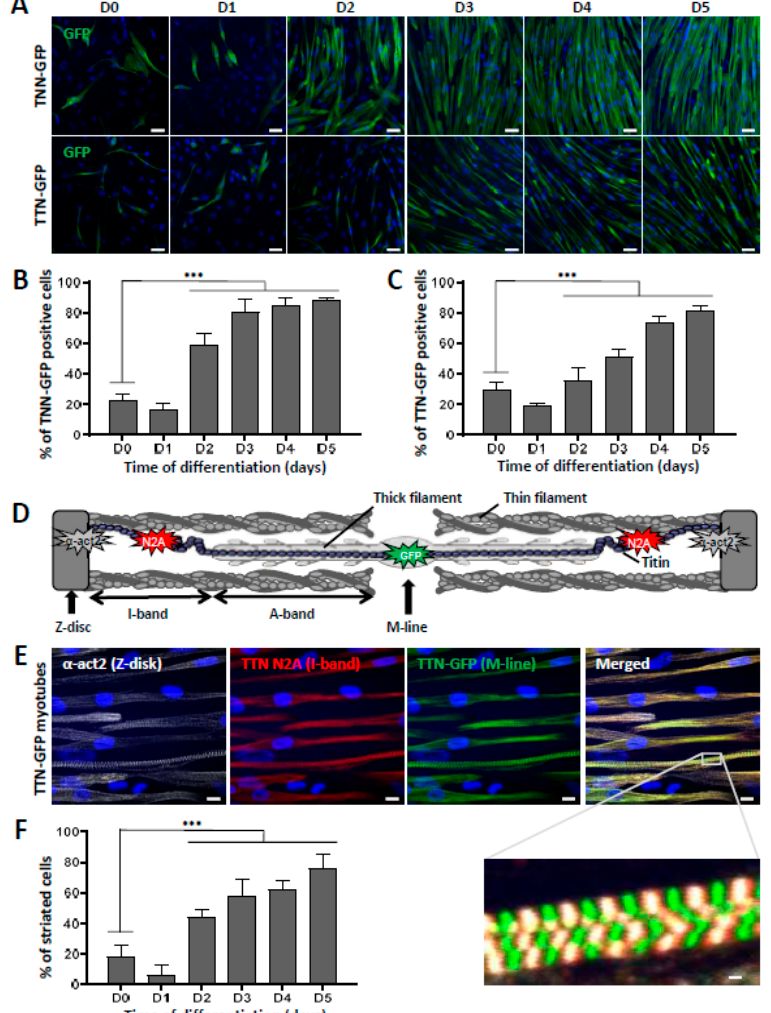
Figure 2. Striation pattern appears during terminal myogenic differentiation. ( A – C ): Troponin I(TNN)- and titin(TTN)-eGFP dynamics during myotube maturation. ( A ) Confocal images of TNN- and TTN-eGFP-tagged cell lines were obtained from day 0 to day 5 after induction of myotube maturation. Nuclei were labeled by Hoechst staining. Scale bar = 50 µ m. Quantification of the percentage of cells terminally differentiated, presented as the percentage of ( B ) TNN- or ( C ) TTN- positive cells out of the total number of myotubes. Each chart represents the mean +/ − SD (n = 5) for a representative experiment; *** p ≤ 0.005 (Student’s t -test). ( D – F ): Analysis of sarcomeric organization during myotube maturation. ( D ) Schematic representation of sarcomeric architecture in skeletal muscle: Z-disk composed of α -actinin, I-band made up of actin thin filaments, A-band comprised of myosin thick filaments, and the M-line where filaments are anchored. Titin spans the entire half-sarcomere: from the Z-disk with the N-terminal extremity to the M-line, by way of the I-band, specifically recognized by the titin N2A antibody. ( E ) Immunofluorescent staining and confocal acquisition of sarcomere structures with TTN-eGFP-tagged cells at day 5 of myotube maturation. Nuclei are labeled by Hoechst staining. Scale bar = 10 µ m. White box denotes an enlargement of co-staining to visualize the cross-striation pattern of myotubes. Scale bar = 1 µ m. ( F ) Quantification of the number of striated cells relative to the total number of skMt during time course differentiation of the TTN-eGFP-tagged cell line. Each chart represents the mean +/ − SD (n = 10) for a representative experiment; *** p ≤ 0.005 (Student’s t -test). Abbreviations: TNN, troponin I; TTN, titin; α -act2,